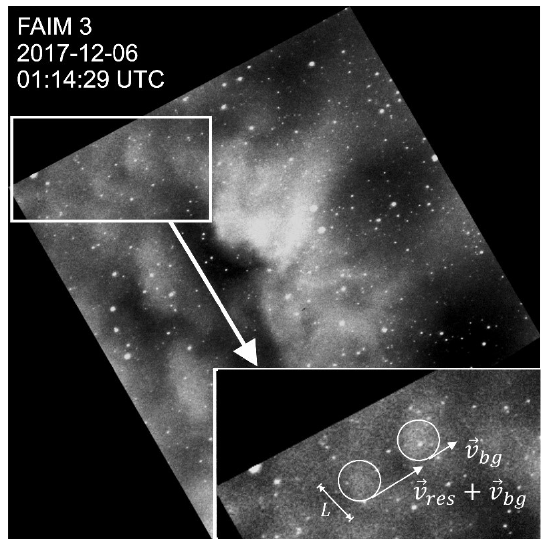
Figure 4. Snapshot (01:14:29UTC) of the turbulence episode from 6 December 2017. Two patches move in the same directions but have different speeds and are approaching each other. While the feature on the right-hand side seems to be advected by the wind (as do the structures in the entire image), the feature on the left-hand side moves even faster and belongs to those structures that creates the impression of turbulent dynamics. The latter patch moves with the residual velocity that is used in Eq. (1) plus the background velocity. The length scale L used in Eq. (1) is given by the size of this feature. This turbulent episode is attached as Video 2 in the Supplement of this